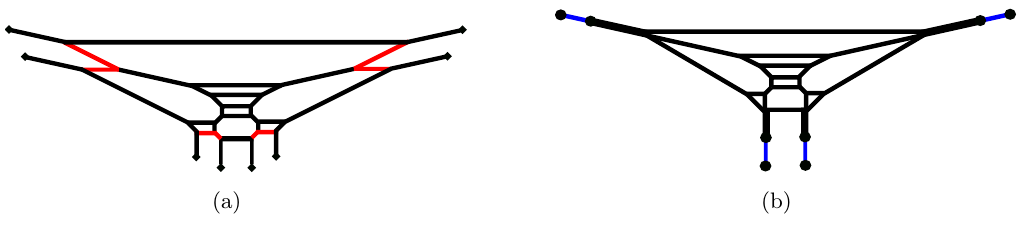
Figure 8 . (a) A 5-brane diagram realizing the SU(3) 0 (cid:0) SU(6) 3 (cid:0) SU(3) 0 quiver theory. (b) The diagram obtained after shrinking red lines in (cid:12)gure